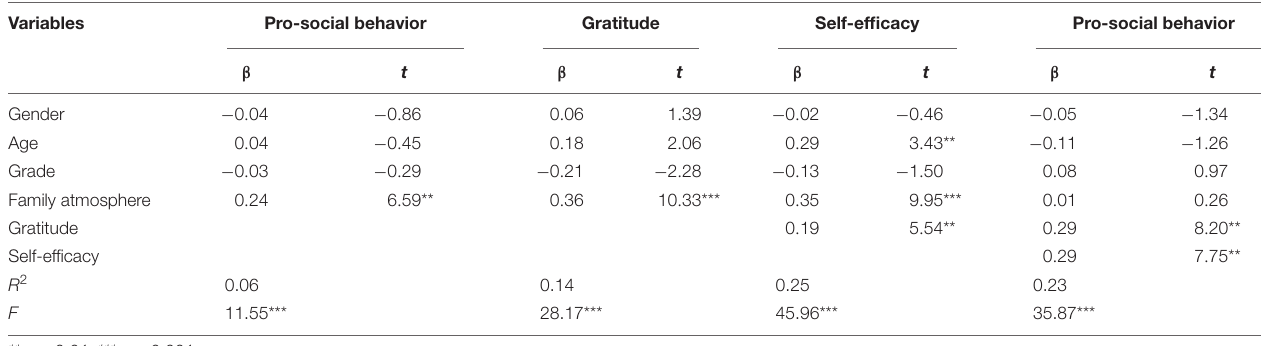
TABLE 2 | Regression analysis of the main variables.